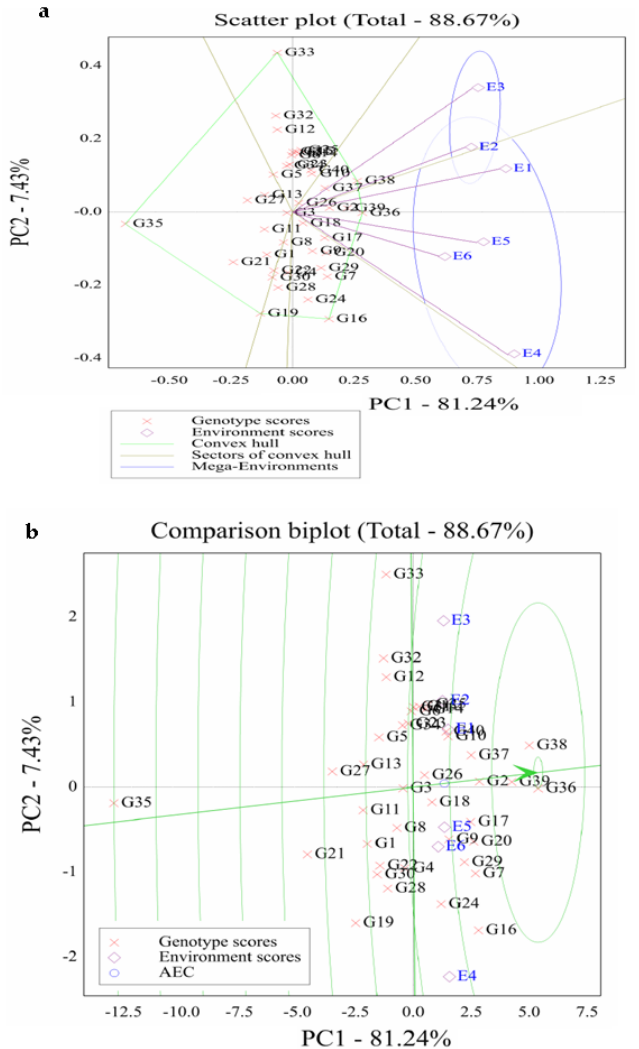
Figure 3. Scatter plot ( a ) and comparison graphic ( b ) of GGE biplot for grain yield of 40 maize hybrids (assessed G1–G40) across six agro-environments (assessed E1–E6). The green arrow directed tested hybrids toward greater grain yield, and the other vertical green line crosses biplot origin displays the stability.